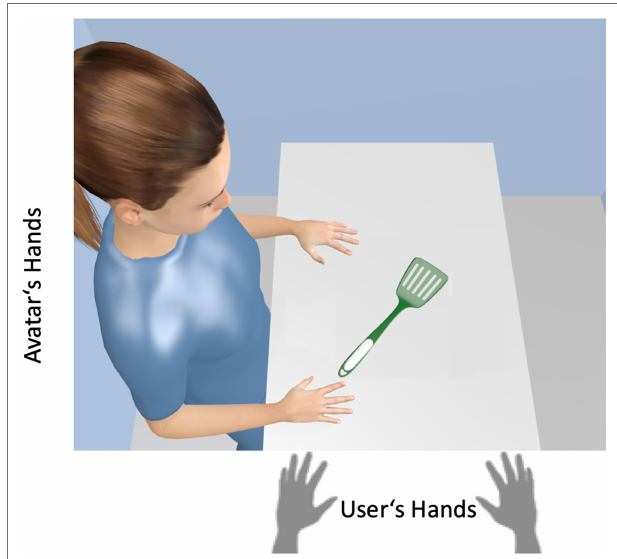
FIGURE 4 | The principle of the avatar-compatibility task. A user controls the left and right hand of an avatar with left and right keystrokes. If the avatar is to grasp the handle of the pan lifter, a right response from the avatar’s point of view should be preferred (which required a right response of the user). However, the handle is oriented to the left from the user’s point of view, which should facilitate a left response. Only if the user takes the perspective of the avatar, the right response should have the advantage. Our findings support consistently this assumption. [“Spatula” (https://skfb.ly/6QWQs) by